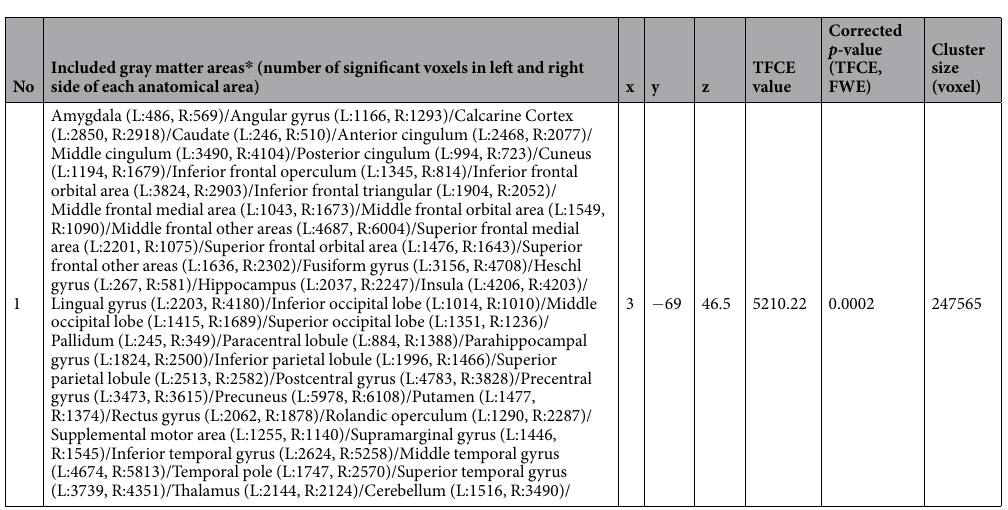
Included gray matter areas * (number of significant voxels in left and right No side of each anatomical area)